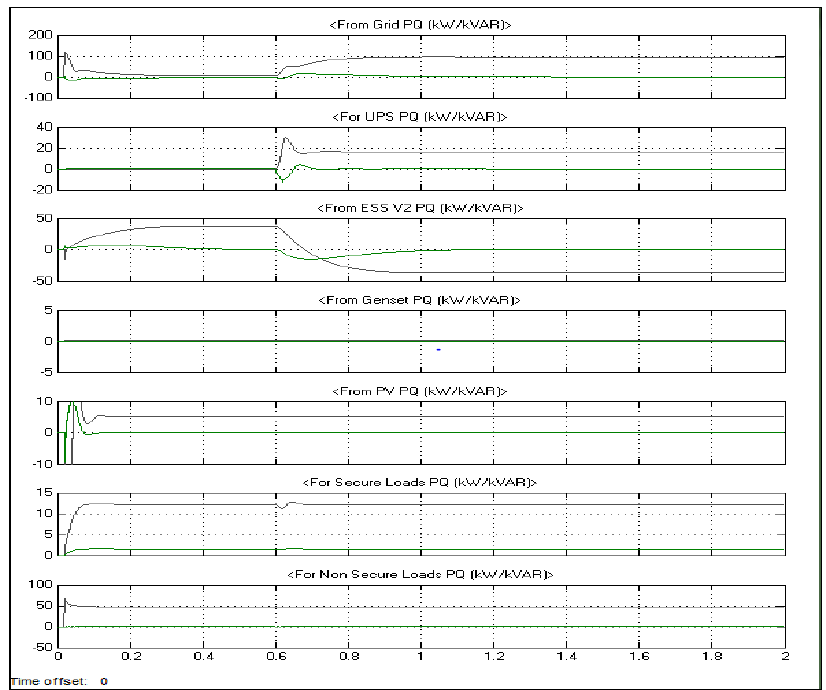
Figure 16. Simulation results in Off Grid mode with PV and BESS as source.